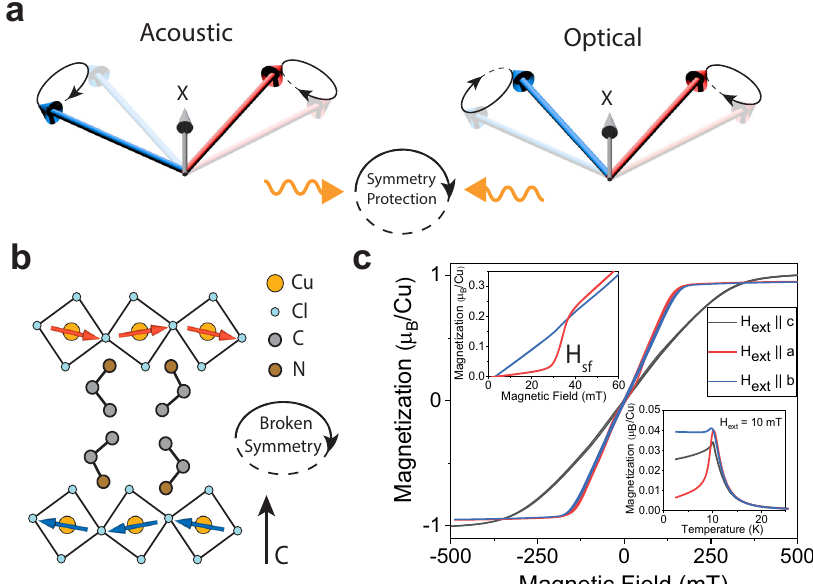
Fig. 1 | Magnetic properties of a hybrid perovskite antiferromagnet. a Schematic illustration of the acousticand optical modesina two-sublattice easy- plane antiferromagnet that are protected from interacting by parity. b A sketch of the inherently low symmetry of the Cu-EA structure due to octahedral tilting and the spin ordering of the layered antiferromagnet and its sublattice structure.